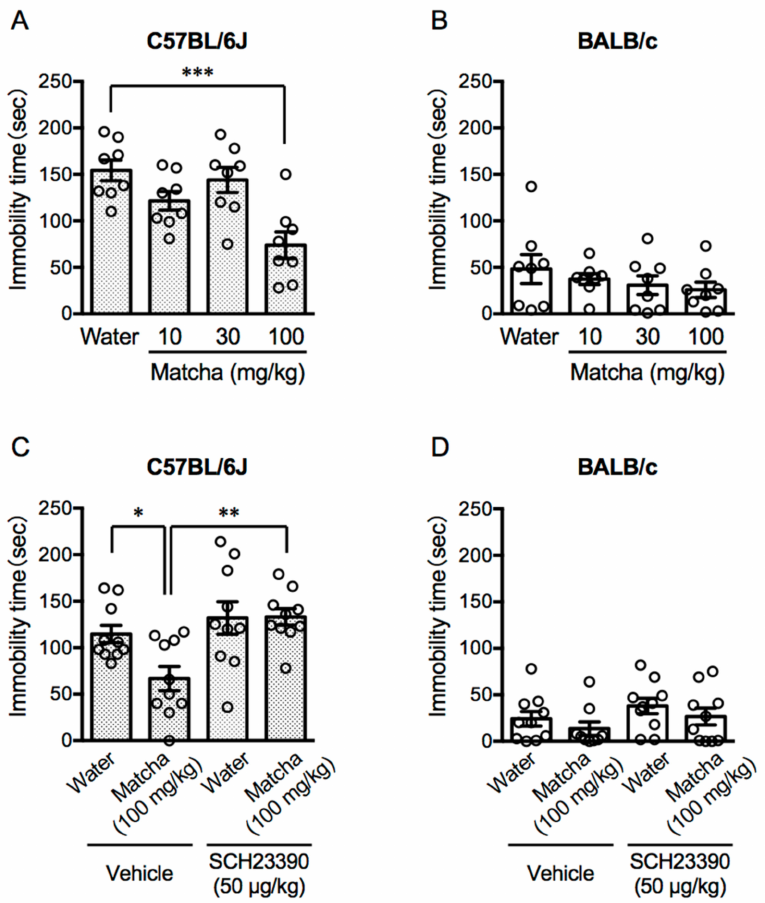
Figure 2. Antidepressant-like effects of Matcha tea powder in stress-vulnerable C57BL/6J mice. The immobility time of C57BL/6J and BALB/c mice in the TST were measured. ( A , B ) The TST was per- formed 30 min after Matcha tea powder administration (10, 30, and 100 mg/kg, p.o.). ( C , D ) SCH23390 (50 µ g/kg, i.p.) was administered 30 min before the Matcha tea powder administration (100 mg/kg, p.o.). The results are expressed as the means ± SEM. n = 8–10 animals. The data were analyzed